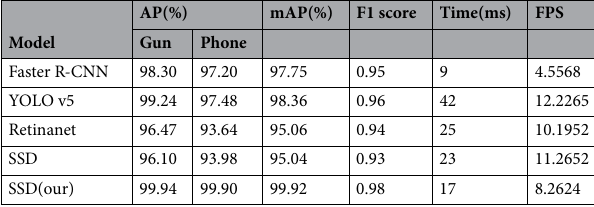
Table 3. Comparison of accuracy with other advanced